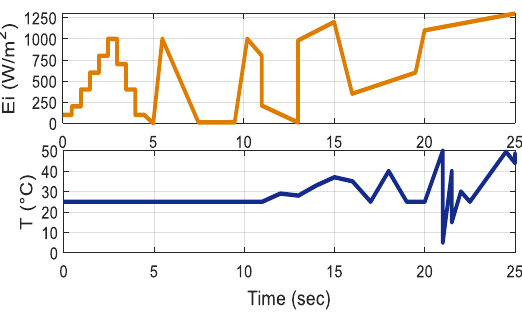
Figure 18. Variable irradiance and temperature signals for a simulation time of 25 s.